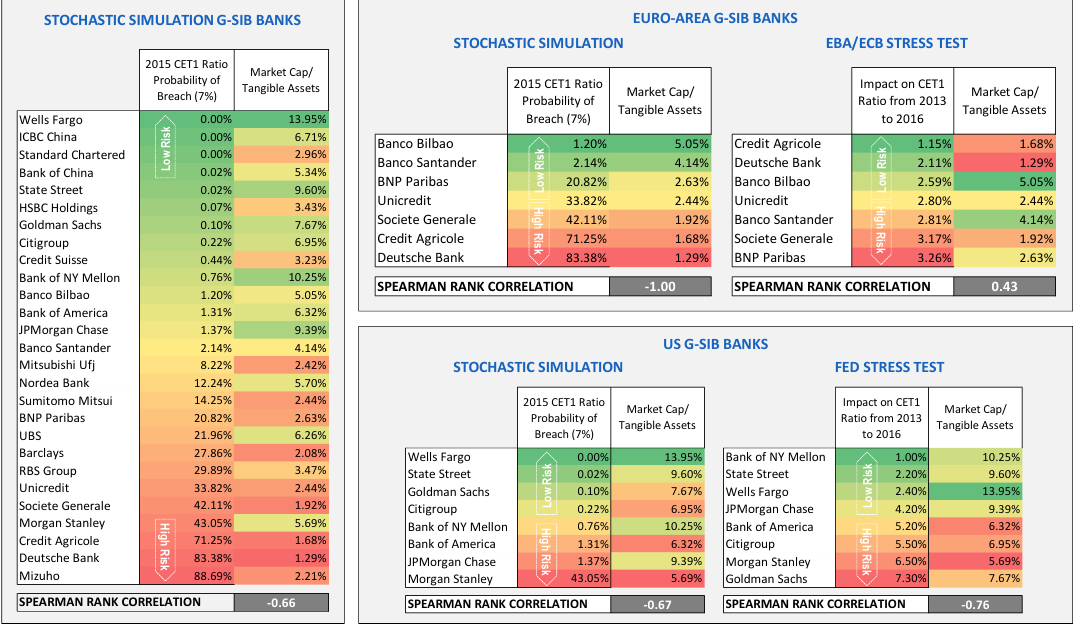
Figure 10. Stochastic Stress Test Analysis vs. Subsequent Market Dynamic. (Source of Market Data: Bloomberg).